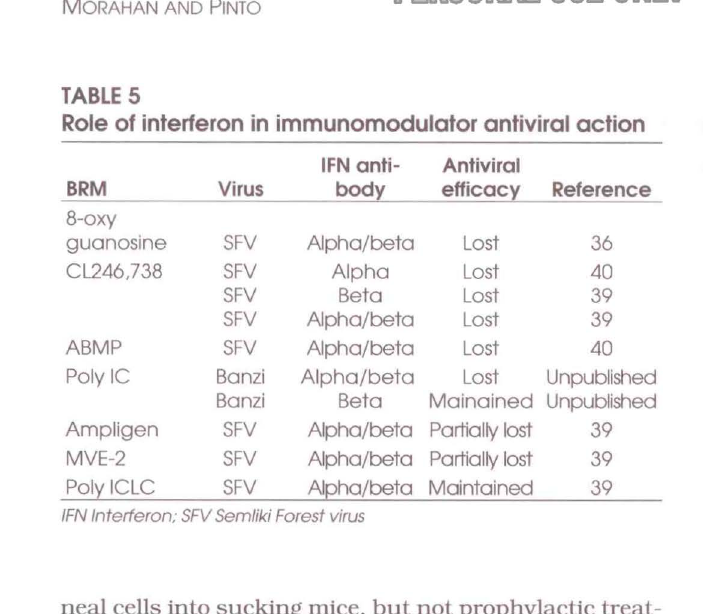
Role of interferon in immunomodulator antiviral action